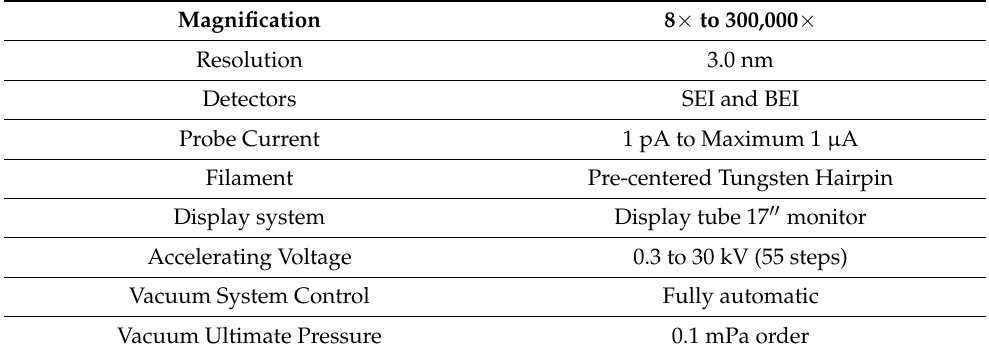
Table 5. Specification of scanning electron microscope used in the recent research